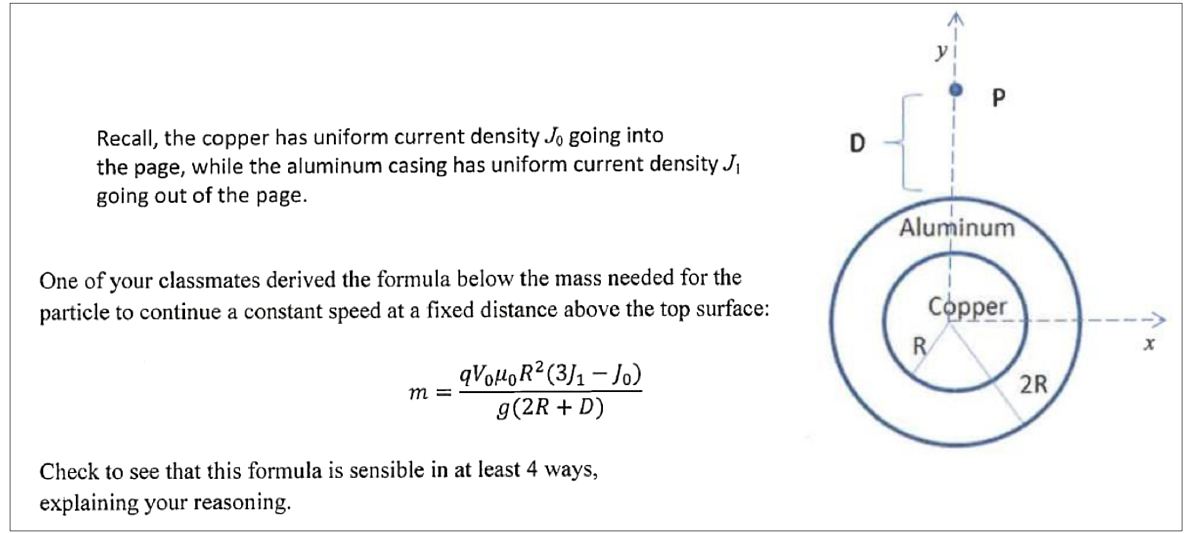
FIG. 15. Aluminum and copper wire problem referenced in Fig. 4, layer 4 of 5. Layer 5 of this exercise was not relevant to this study and is not included here.